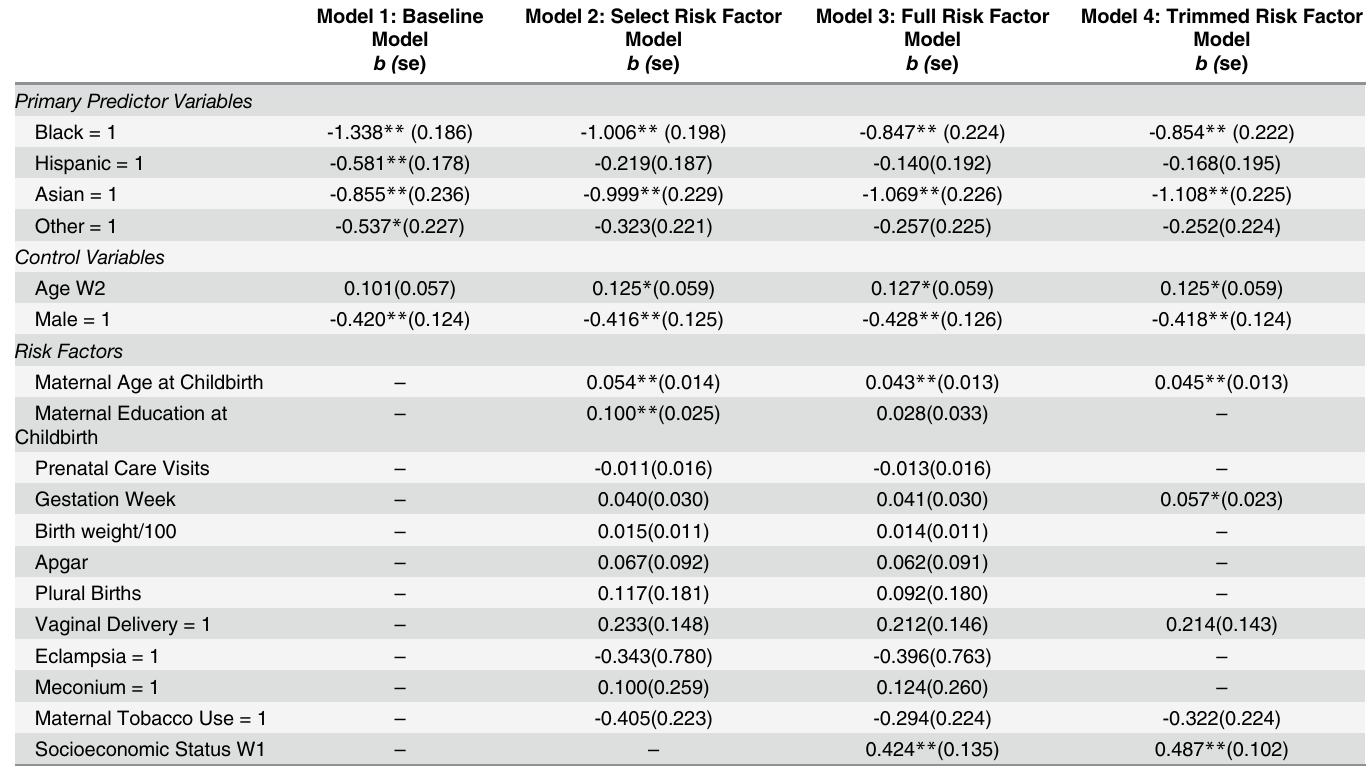
Table 2. OLS Regression of Self-regulation on Control Variables and Risk Factors ( n (cid:1)